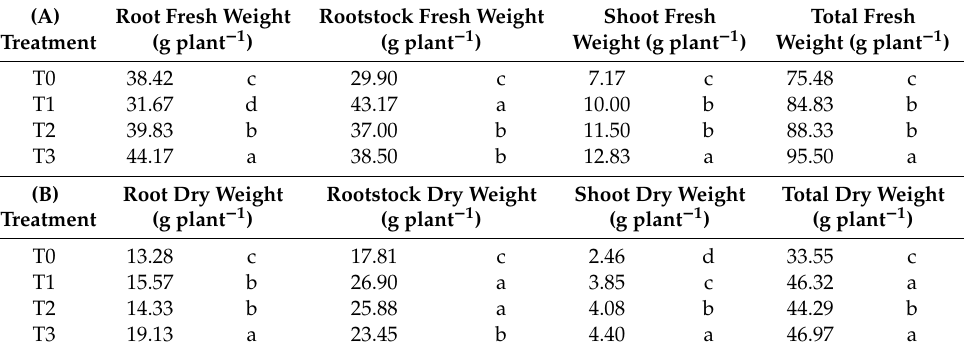
Table 4. Agronomic parameters recorded on bare-rooted